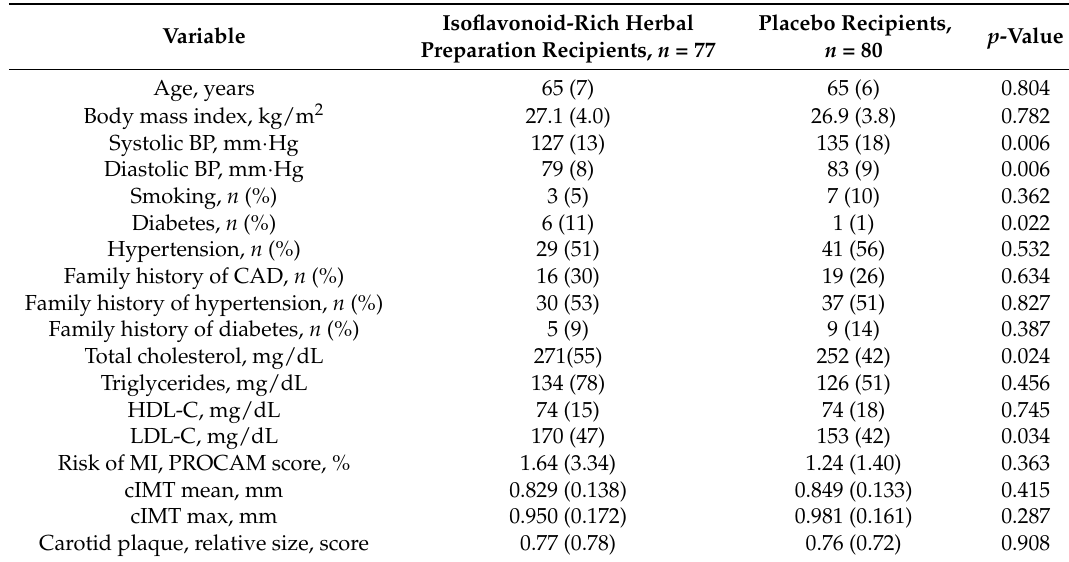
Table 1. Baseline characteristics of study